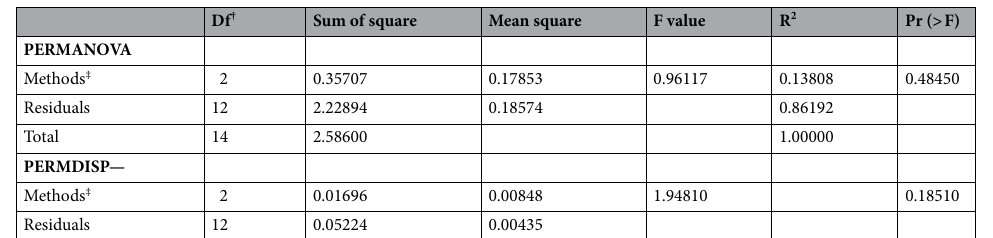
Table 4. Statistical results of Permutational Multivariate Analysis of Variance (PERMANOVA) and Permutational Multivariate Analysis of Dispersion (PERMDISP) for comparisons of species composition among iSeq, MiSeq, and conventional methods. † Degree of Freedom (Df) † Degree of Freedom (Df). ‡ Species detection methods (iSeq, MiSeq, and Conventional).